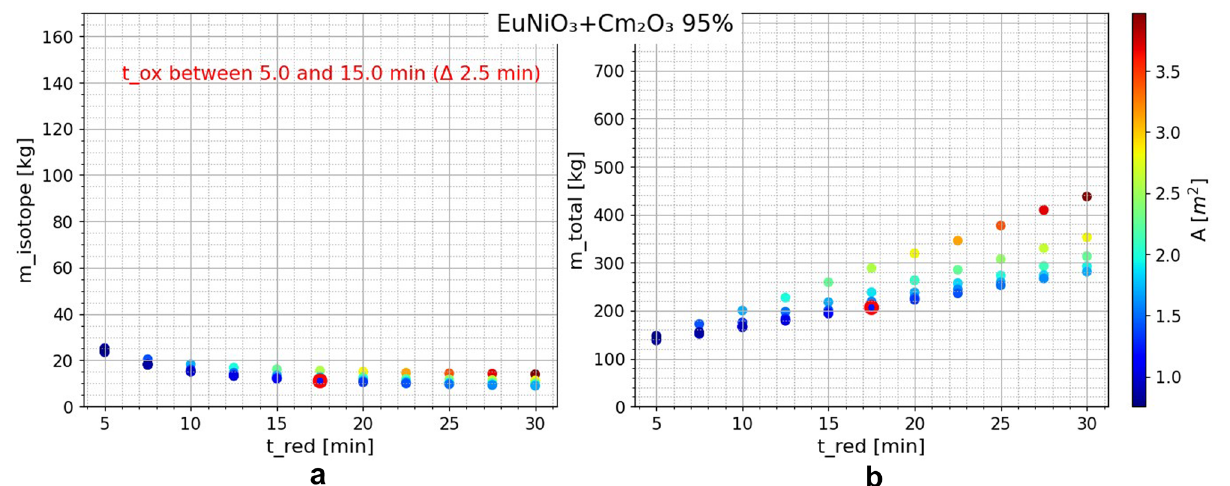
Figure 6. EuNiO 3 -Cm 2 O 3 (95% 244 Cm) calculation results for ( a ) isotope mass m RI , ( b ) total curtain mass m total , (color) reactor chamber cross-sectional area A over t ox (projected axis) and t red (x-axis) variation; T ox = 300 ◦ C , T red = 500 ◦ C ;